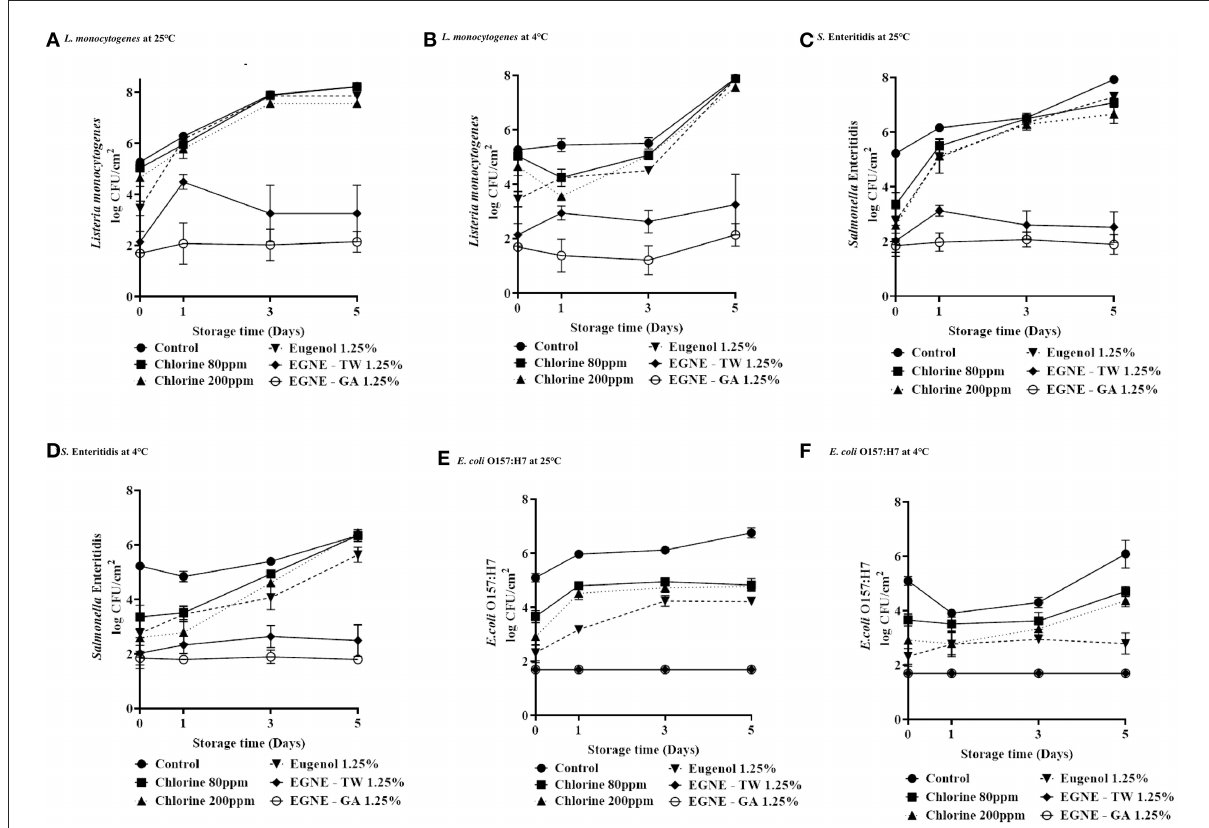
FIGURE3 Survival of L. monocytogenes (A,B) , S. Enteritidis (C,D) and E. coli O157:H7 (E,F) (log CFU/cm 2 ) on cantaloupe washed with eugenol nanoemulsions during the 5-day storage at 25 and 4 ◦ C (A,B) . Error bar represents SEM ( n = 6). The treatment groups are control, chlorine 80 ppm, chlorine 200 ppm, Eugenol 1.25%, EGNE-GA 1.25%, and EGNE-TW